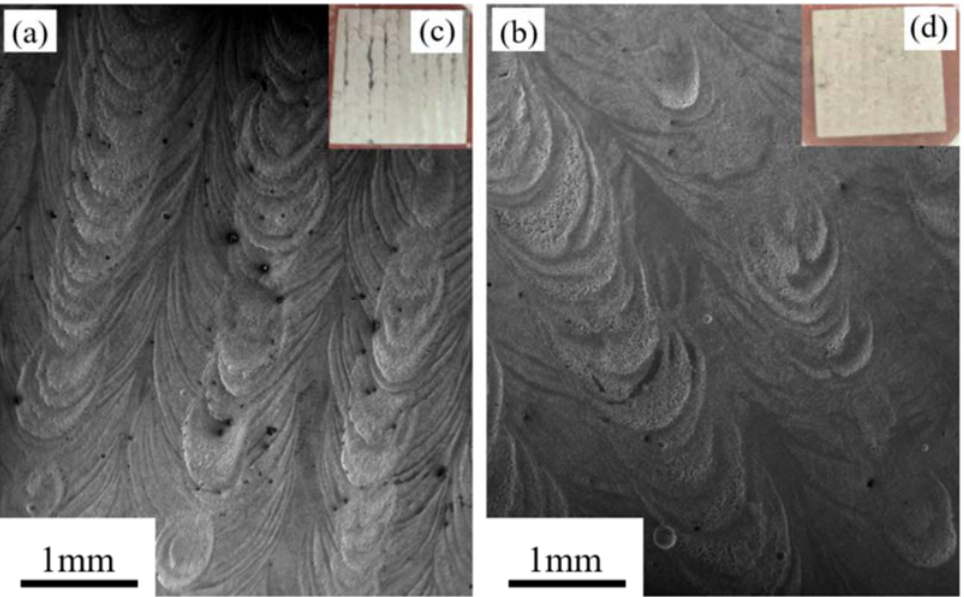
Figure 11. SEM images and macroscopic morphologies of the LMD HEA after electrochemical tests: ( a,c ) XY ‐ plane and ( b,d ) YZ ‐ plane.